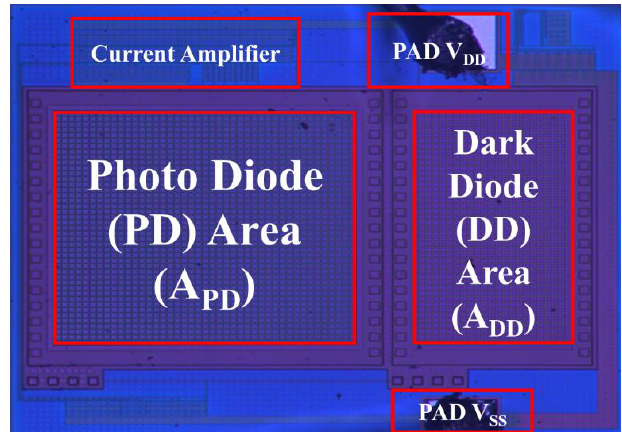
Figure 17. Microphotograph of the proposed CMOS light detector.